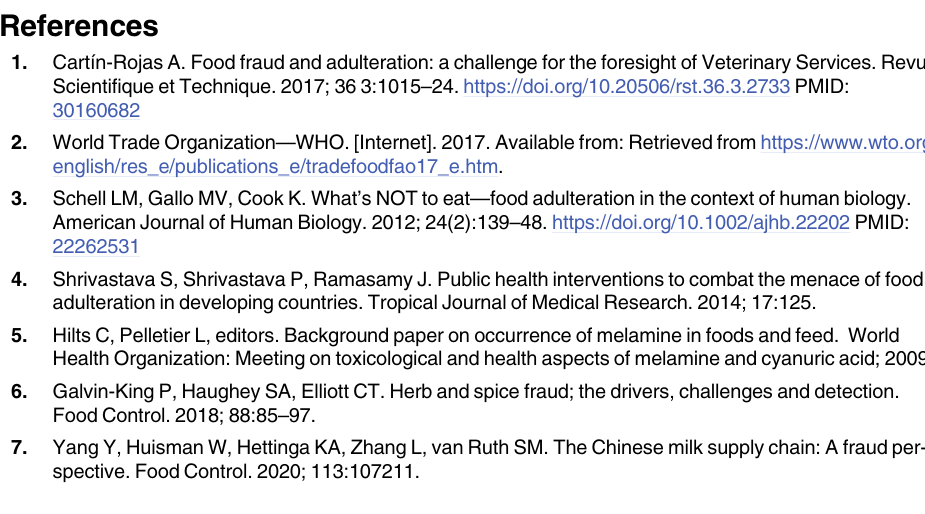
S1 Fig. Graphical